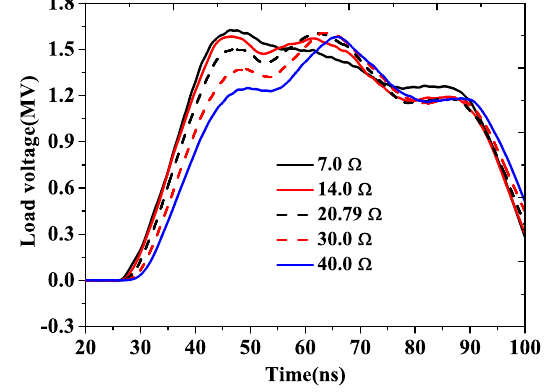
FIG. 9. Load voltage waveforms obtained by 2D circuit simulation when the azimuthal transmission line impedance is 5.0, 10.0, 14.0, 20.79 and 40 . 0 Ω .